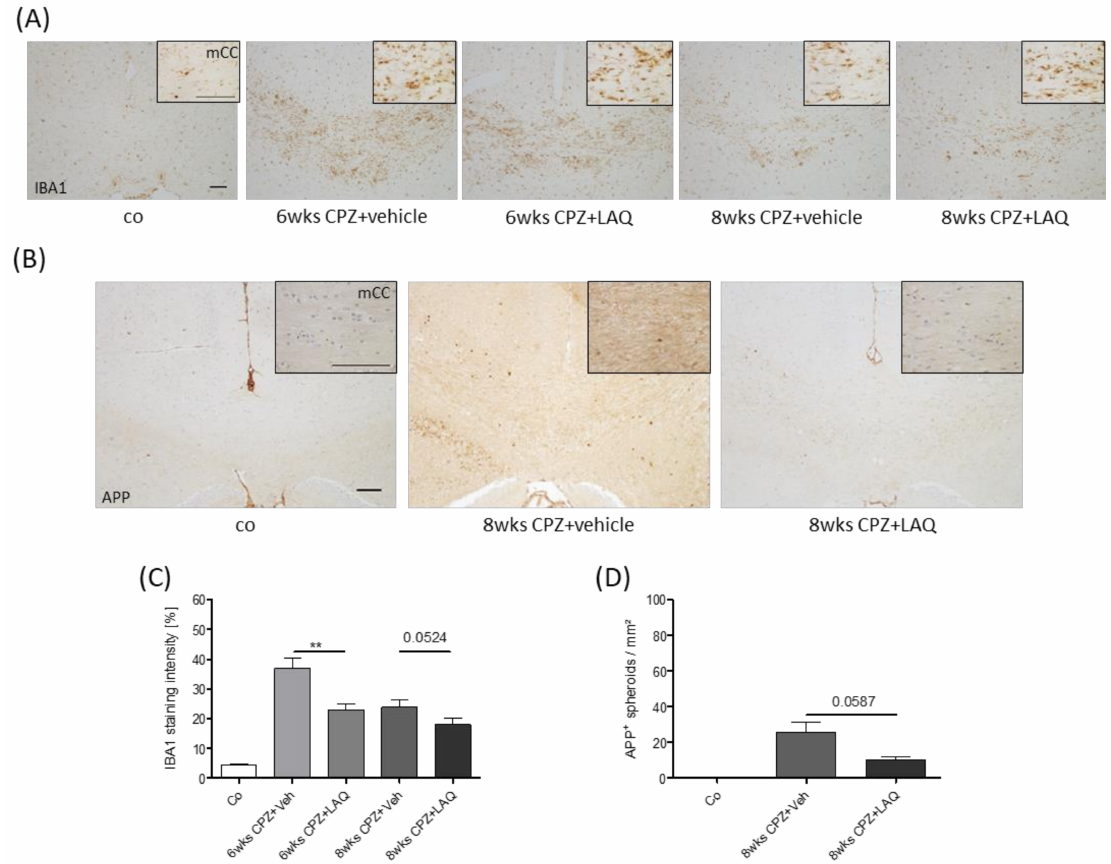
Figure 3. Microglia / monocyte accumulation and axonal damage. ( A ) Accumulation of microglia / monocytes visualized by anti-IBA1 immunohistochemistry. Inserts show the medial corpus callosum in higher magnification. ( B ) Axonal injury visualized by anti-APP